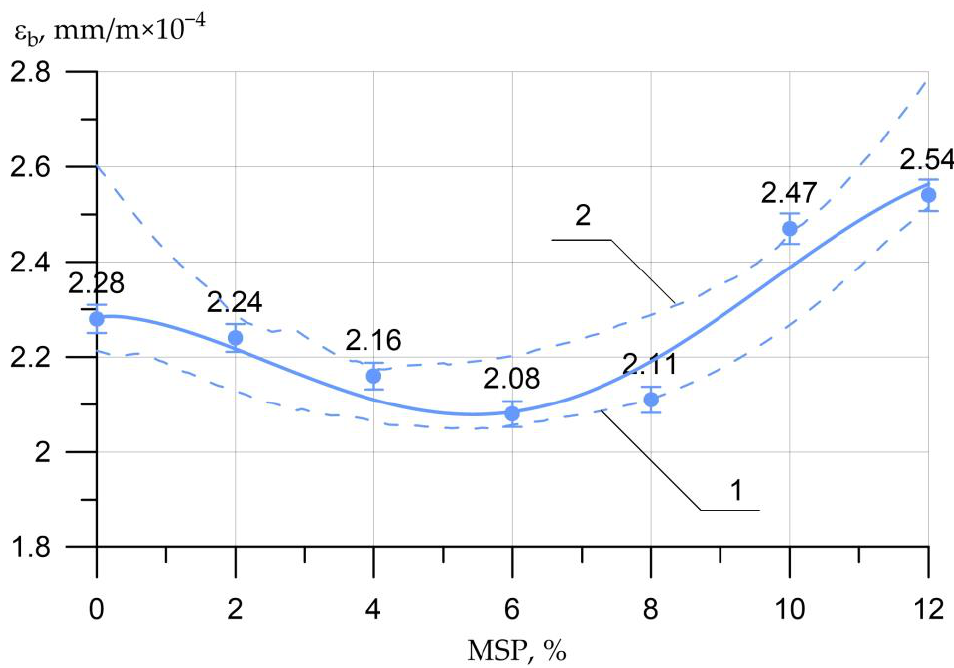
Figure 8. Dependence of the axial TS of concrete R bt on the amount of MSP: 1—lower confidence level; 2—upper confidence level.